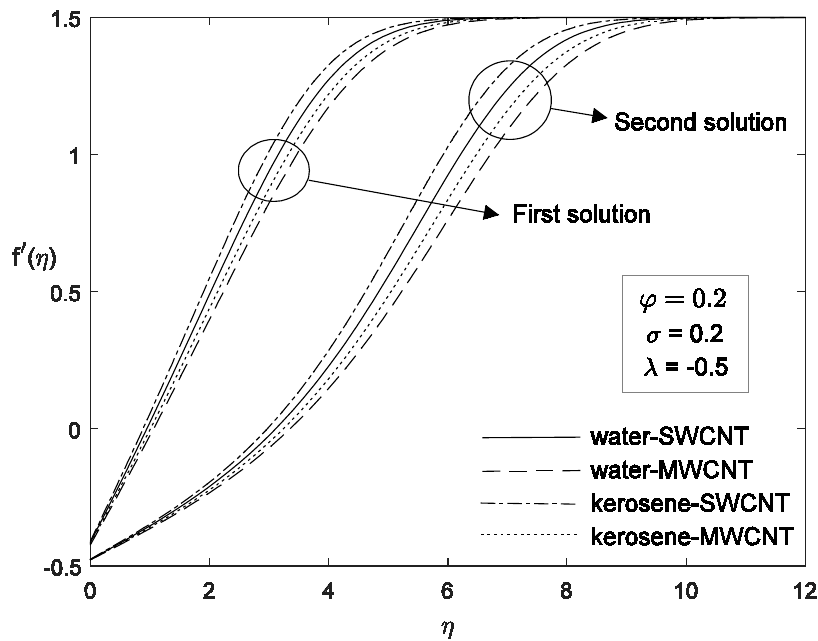
Figure 22. Effect of various nanoparticles on velocity profile.